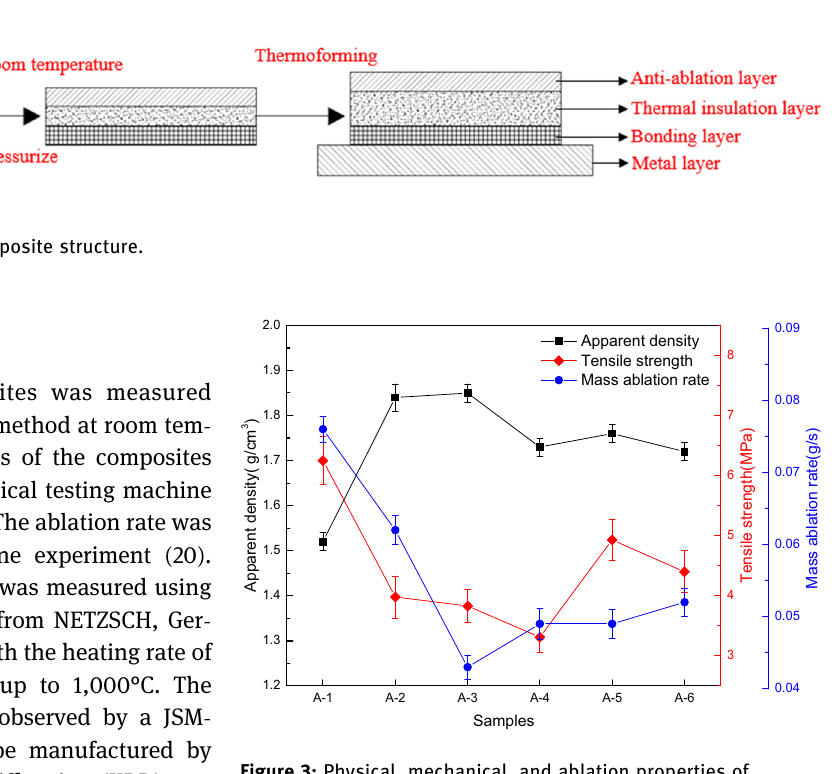
Figure 3: Physical, mechanical, and ablation properties of